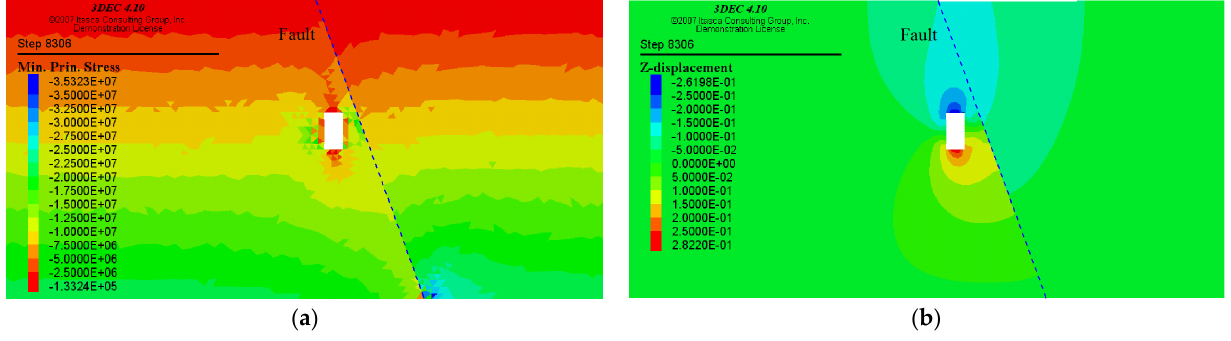
Figure 2. Nephogram of stress and displacement distribution of surrounding rock when the mining area is 60 m away from the fault footwall, they should be listed as: ( a ) Maximum principal stress nephogram; ( b ) Vertical displacement nephogram.